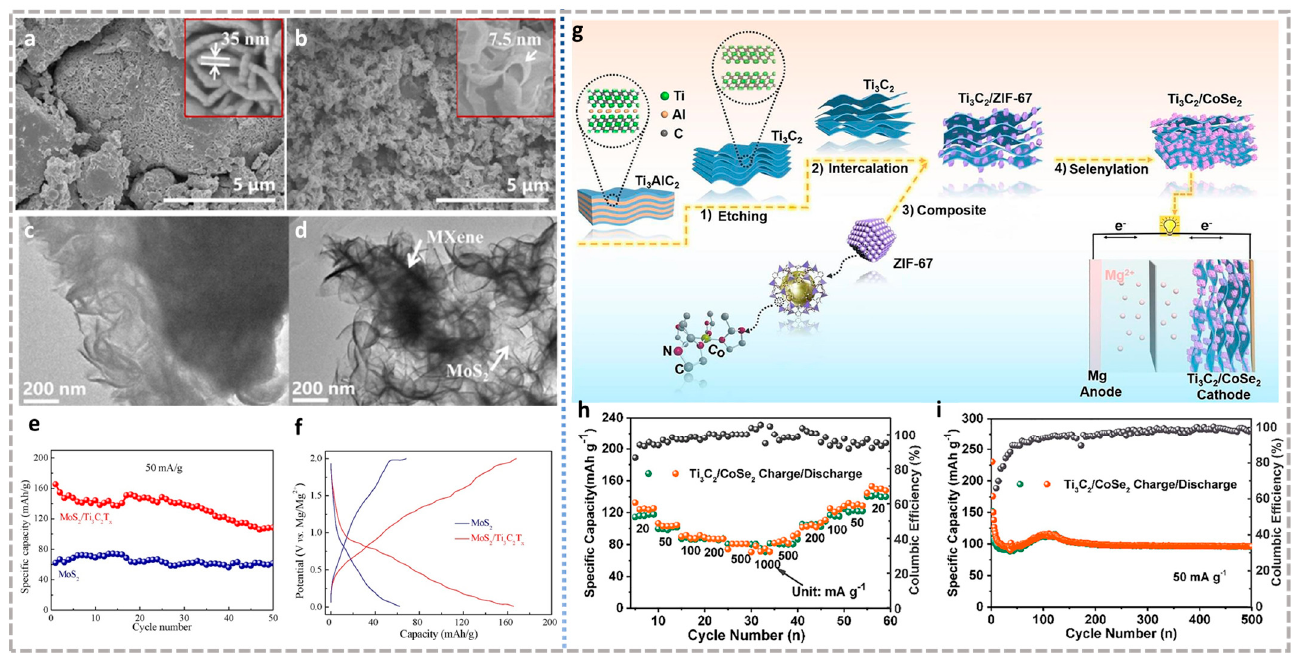
Figure 7. FESEM and TEM images of ( a , b ) MoS 2 and ( c , d ) MoS 2 /Ti 3 C 2 T x composite. The illustrations show the corresponding image with di ff erent magni fi cations. ( e ) Cycle performance and ( f ) charge/discharge curves of MoS 2 and MoS 2 /Ti 3 C 2 T x electrodes in MIBs after stabilization [89]. ( a – f ) Reproduced with permission from Elsevier. ( g ) Schematic illustration of the Ti 3 C 2 /CoSe 2 synthesis process and half-cell mechanism. ( h ) Rate capability at di ff erent current densities and ( i ) cycling performance at 50 mAg − 1 of Ti 3 C 2 /CoSe 2 [91]. ( g – i ) Reproduced with permission from Elsevier BV.